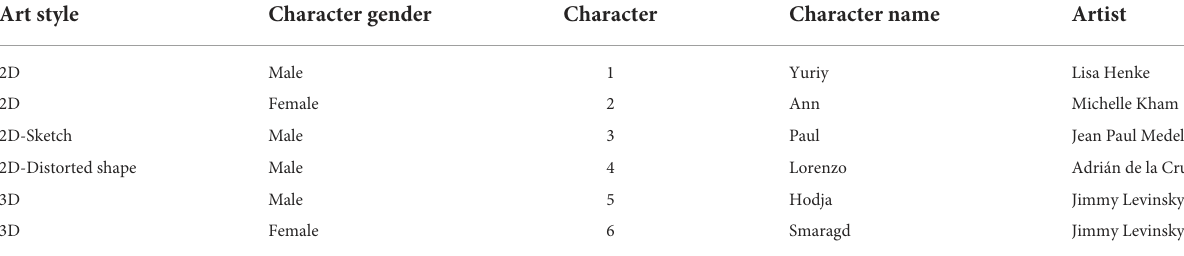
TABLE 1 Character designs used in the questionnaire and their